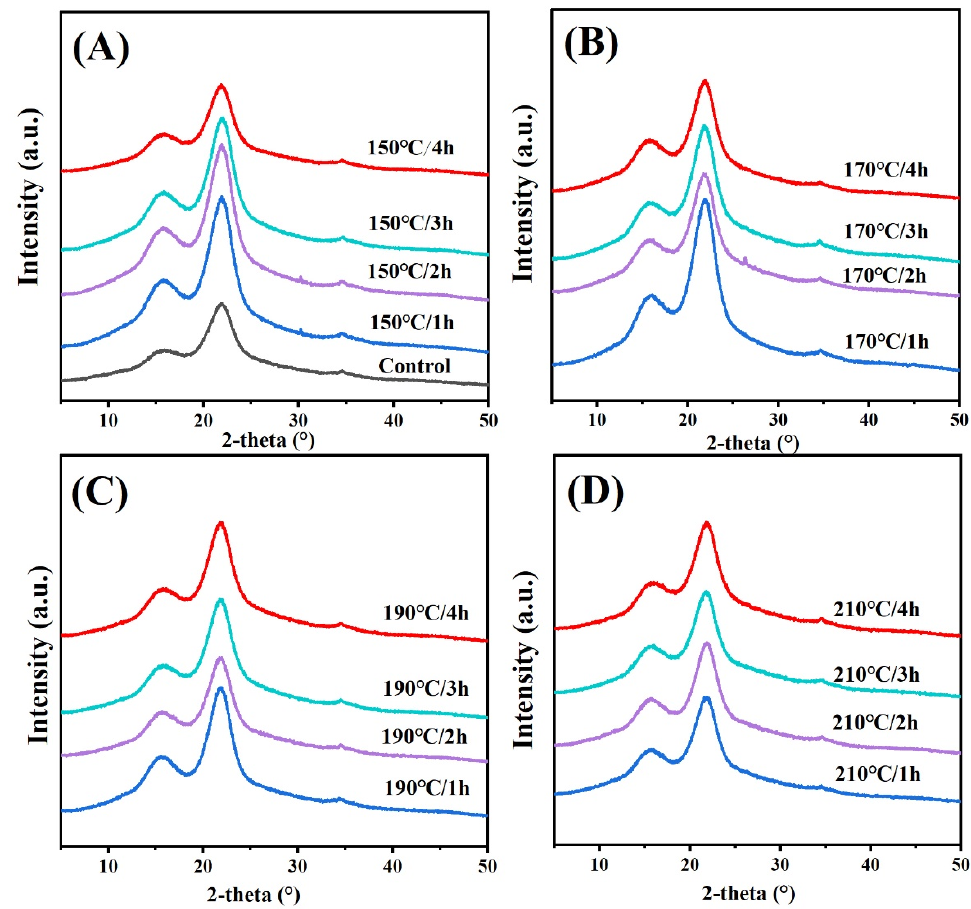
Figure 7. XRD curves of different bamboo specimens after nitrogen heat treatment.